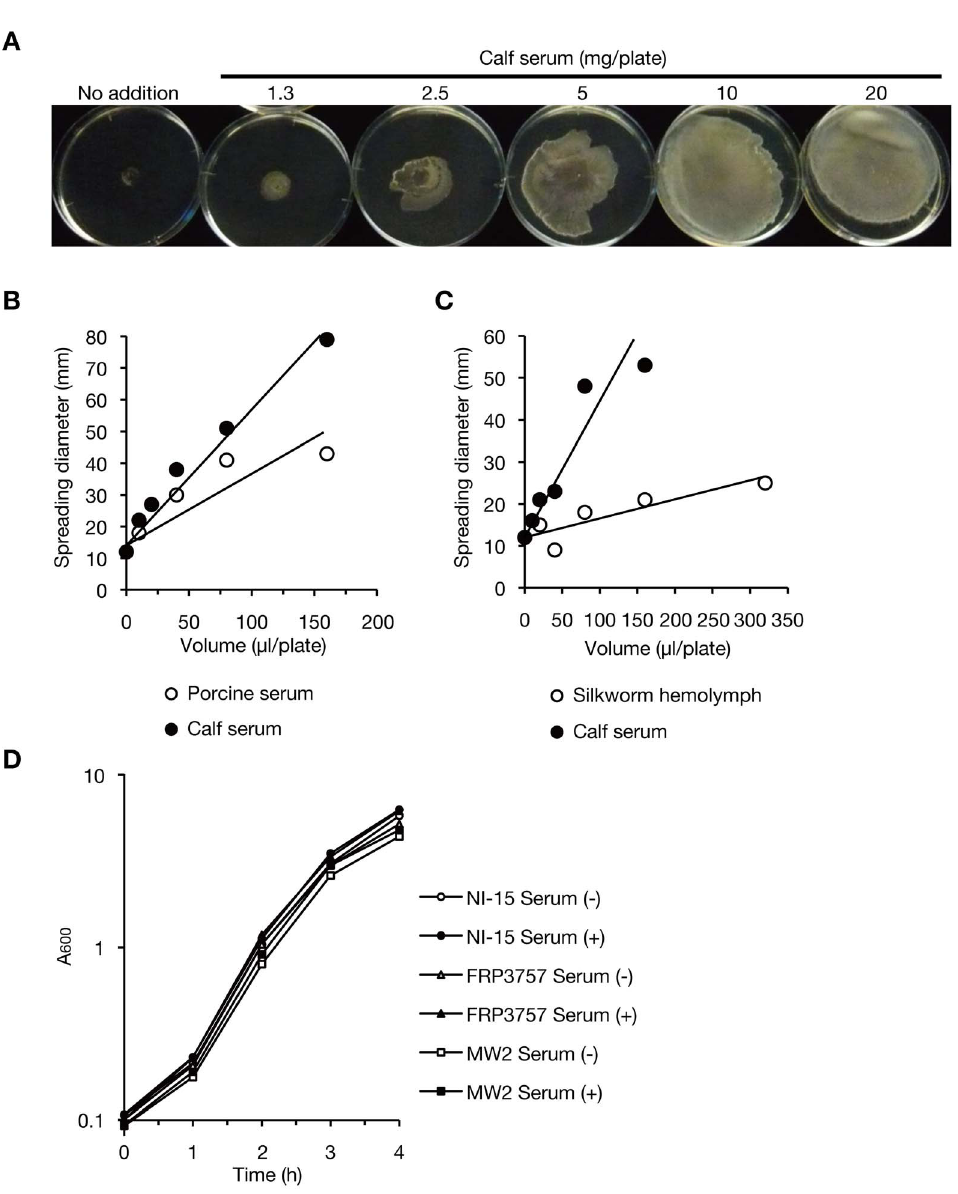
Figure 1. Mammalian serum stimulates S.aureus colony-spreading activity . (A) Stimulation of colony-spreading activity by calf serum. Overnight culture of S. aureus MRSA NI-15 was spotted on soft agar supplemented with serially diluted calf serum and incubated for 8 h at 37 u C. Each plate contained 20 ml soft agar medium. (B) Stimulation of colony-spreading by porcine serum. Porcine serum or calf serum was serially diluted 2-fold and applied to 20 ml soft agar medium and its colony-spreading stimulatory activity was measured. Open circles indicate the halo diameters of giant colonies supplemented with porcine serum and filled circles indicate those supplemented with calf serum. Horizontal axis represents the volume of serum added to 20 ml soft agar medium in a plate. (C) Stimulation of colony-spreading activity by silkworm hemolymph. Hemolymph was collected from fifth instar larvae of silkworms and applied to the soft agar plates in 2-fold serial dilutions and its colony-spreading stimulatory activity was measured. Open circles indicate the halo diameters of giant colonies supplemented with silkworm hemolymph and filled circles indicate those supplemented with calf serum. (D) Growth curves of MRSA NI-15, MW2, or FRP3757 in tryptic soy broth supplemented with or without 1.25% (v/v) calf